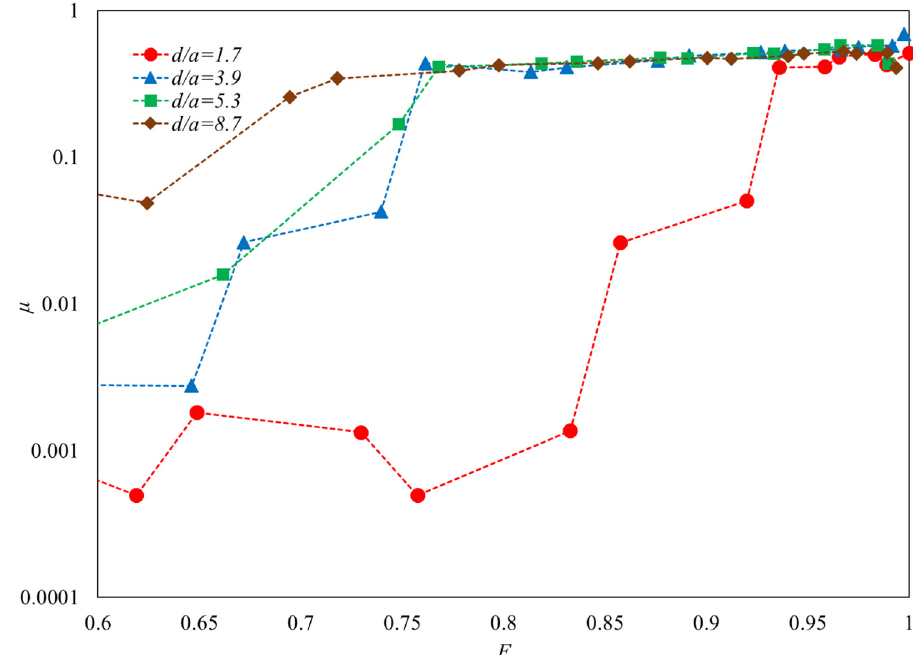
Fig. 8. Penetration ratio m against solid fraction F for different d/a ratios at b